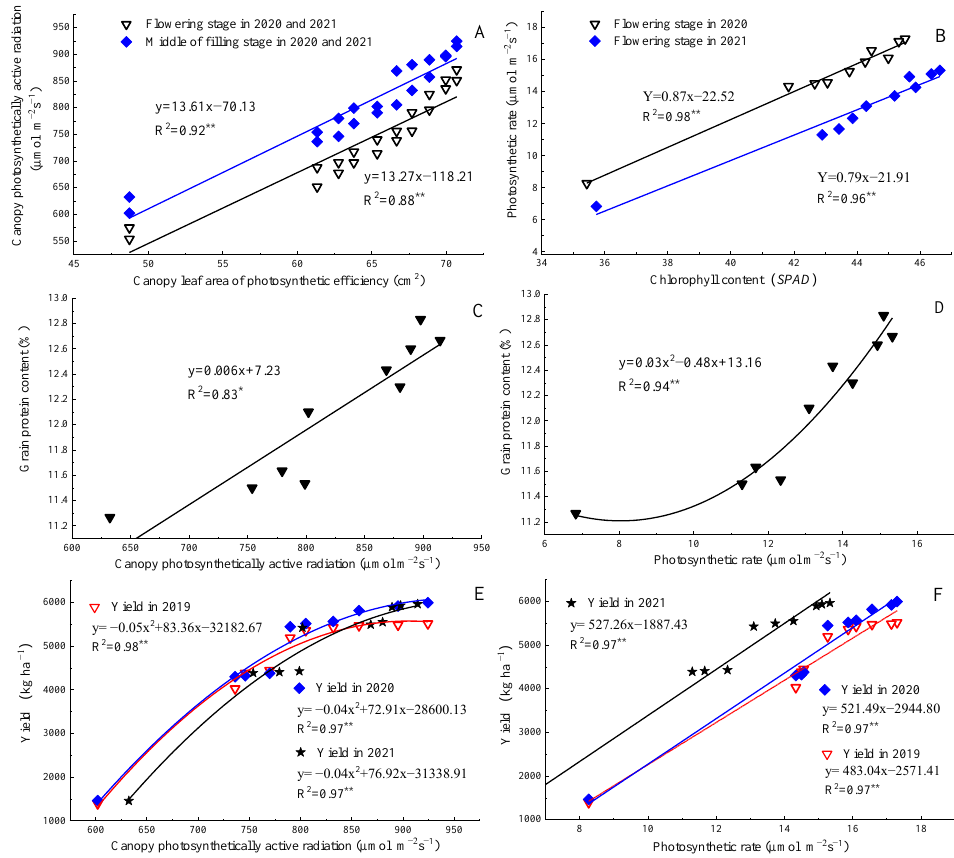
Figure 4. Relationship between canopy leaf area of photosynthetic efficiency and canopy photosyn- thetically active radiation ( A ), chlorophyll content and photosynthetic rate ( B ), canopy photosyntheti- cally active radiation and grain protein content ( C ), photosynthetic rate and grain protein content ( D ), canopy photosynthetically active radiation and yield ( E ), photosynthetic rate and yield ( F ). * Correlation is significant ( p < 0.05); ** Correlation is markedly significant ( p < 0.01).